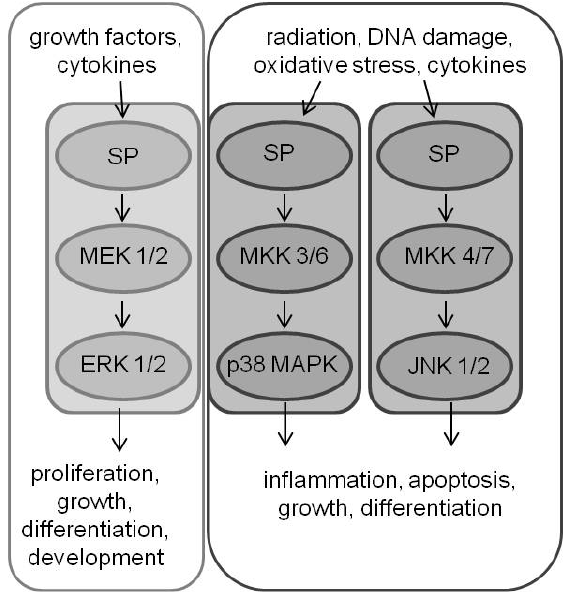
Figure 1 : MAPK pathways. Scaffold proteins (SP) are kinases upstream of the MAP kinases, which are activated through mediators such as cytokines or growth factors. MEK 1/2 and MKKs (mitogen-activated protein kinase kinases) are among the SPs. The kinases ERK 1/2, p38 MAPK or JNK 1/2 are subsequently activated. These enzymes induce different cellular processes e.g. proliferation or apoptosis [19]. Image adapted from